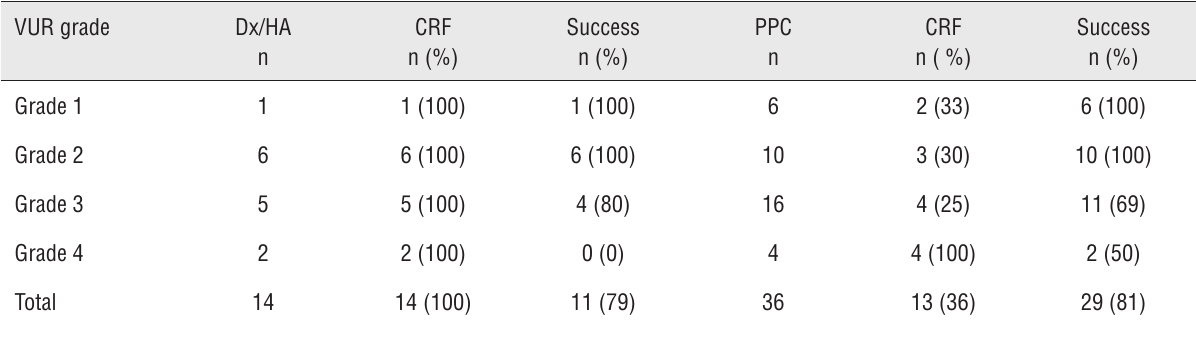
Table 1 - VUR grades of renal units, injection materials, rate of chronic renal failure and treatment success. CRF: chronic renal failure, DxHA: dextranomer/hyaluronic acid copolymer, PPC: polyacrylate polyalcohol copolymer. VUR